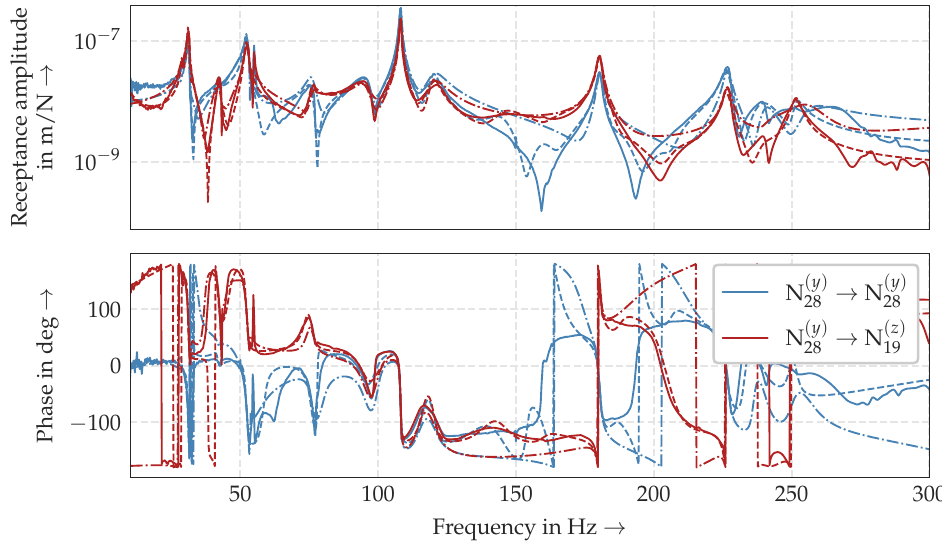
Figure 10. Comparison of the receptance amplitude and the phase between measured (solid) and fitted FRFs (MATLAB ® : dash-dotted, AutoEMA: dashed) from the modal model for position z 2 ; ( β 1 ) ( β 2 ) N α 1 → N α 2 denotes the FRF between a force excitation at node N α 1 in coordinate direction β 1 and the measured displacement at node N α in coordinate direction β 2 (see Table 5). 2 Table 7. FRAC value statistics for FRFs measured for WPT position z 2 for the machine tool use case.